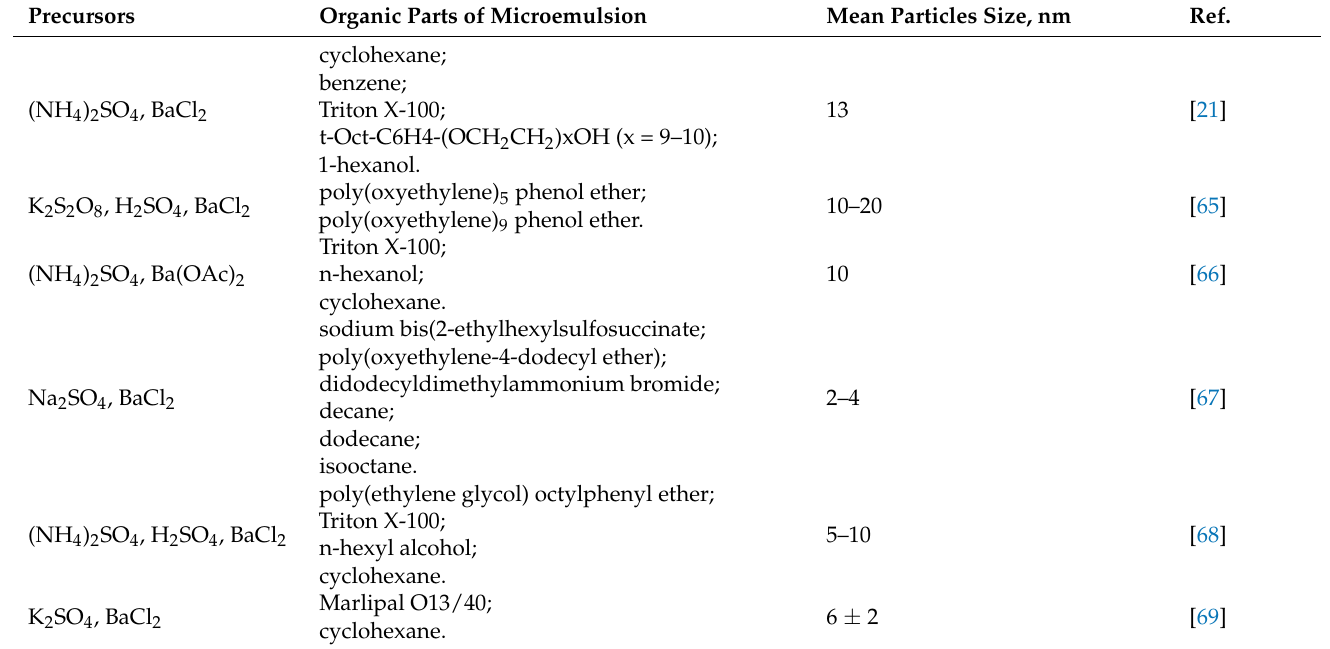
Table 2. Conditions for obtaining barium sulfate nanoparticles by using microemulsions, described in the